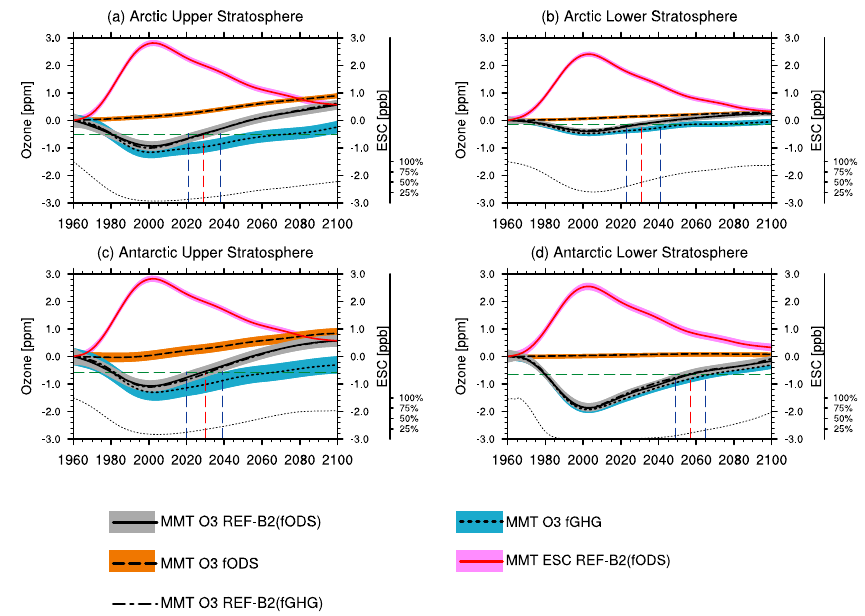
Fig. 8. Same as Fig. 2, but ozone in polar regions in the Arctic (March mean, upper row) and in the Antarctic (October mean, lower row). The upper stratosphere is shown for the 5hPa level and the lower stratosphere for the 50hPa